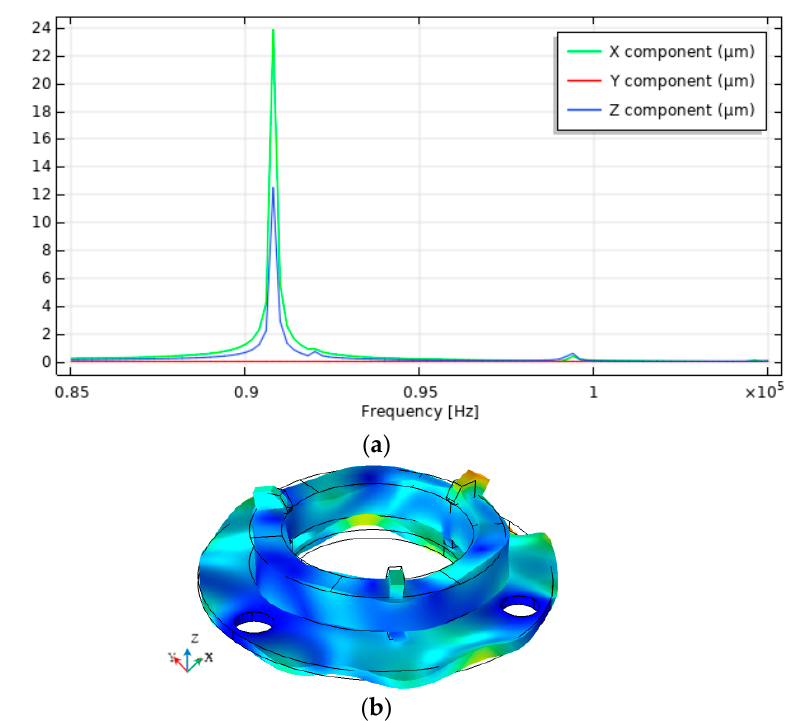
Figure 5. Results of harmonic response analysis when the top electrode is divided into six equal segments: ( a ) amplitude-frequency characteristic; ( b ) vibration modes at 90.80 kHz.